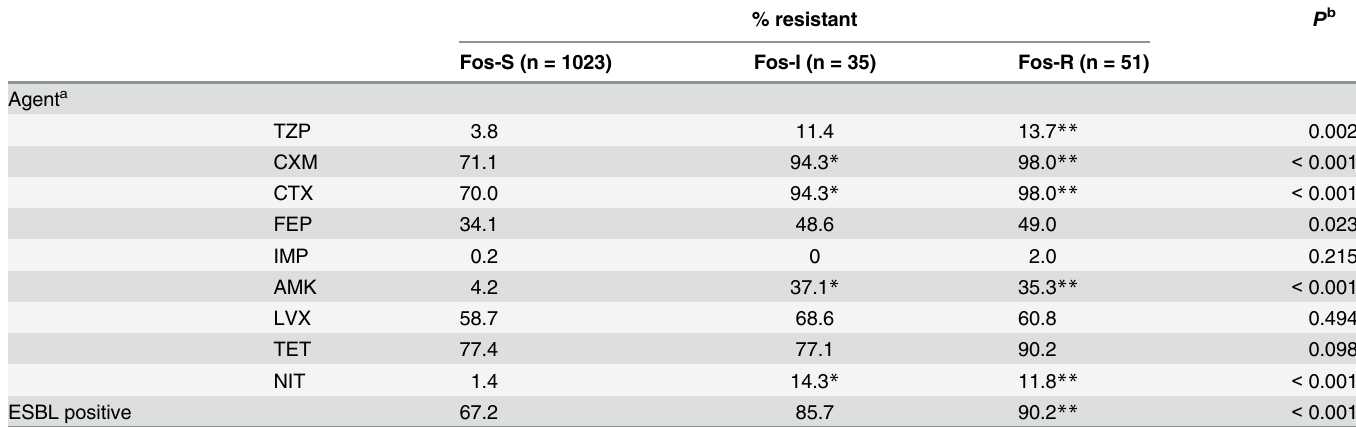
Table 3. Antimicrobial resistance of Escherichia coli stratified by fosfomycin